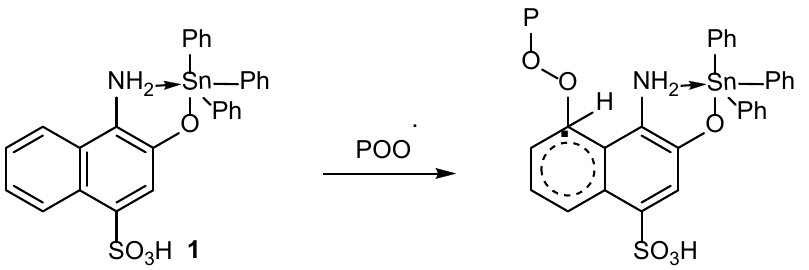
Figure 12. Complex 1 acts as a scavenger for HCl.